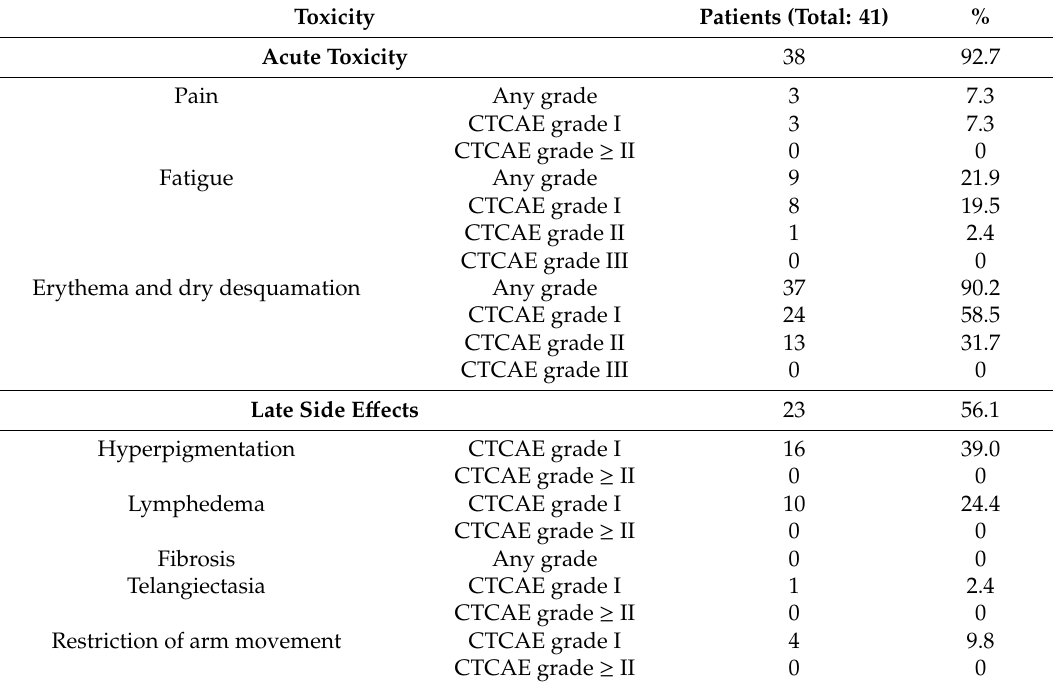
Table 2. Acute toxicity and late side e ff ects of